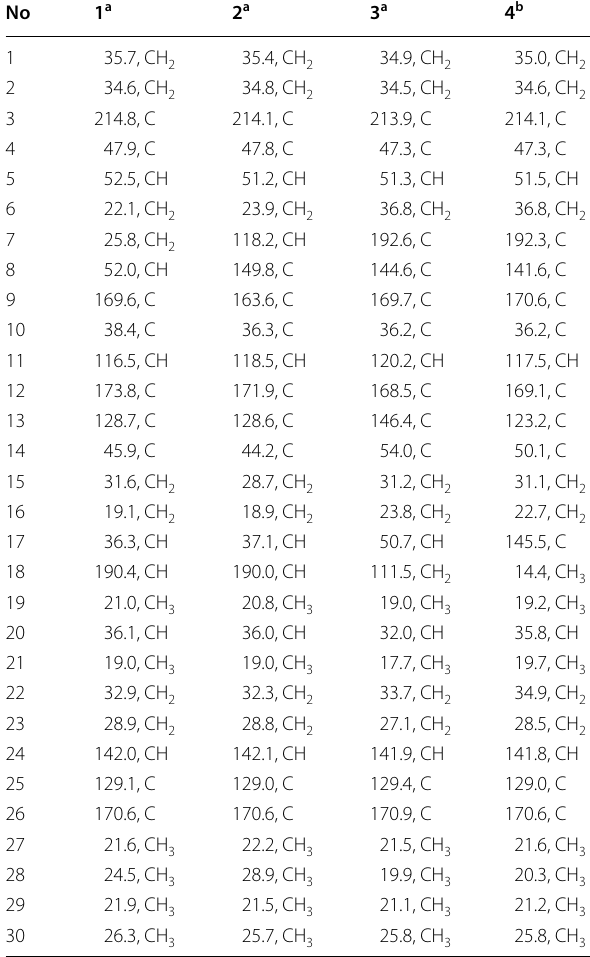
Table 2 13 C NMR data of compounds 1 – 4 ( δ in